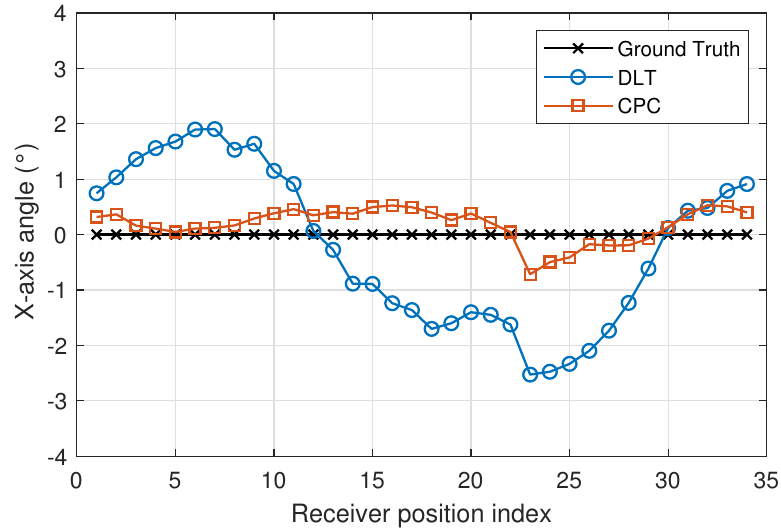
Figure 13. X-axis angle using DLT and